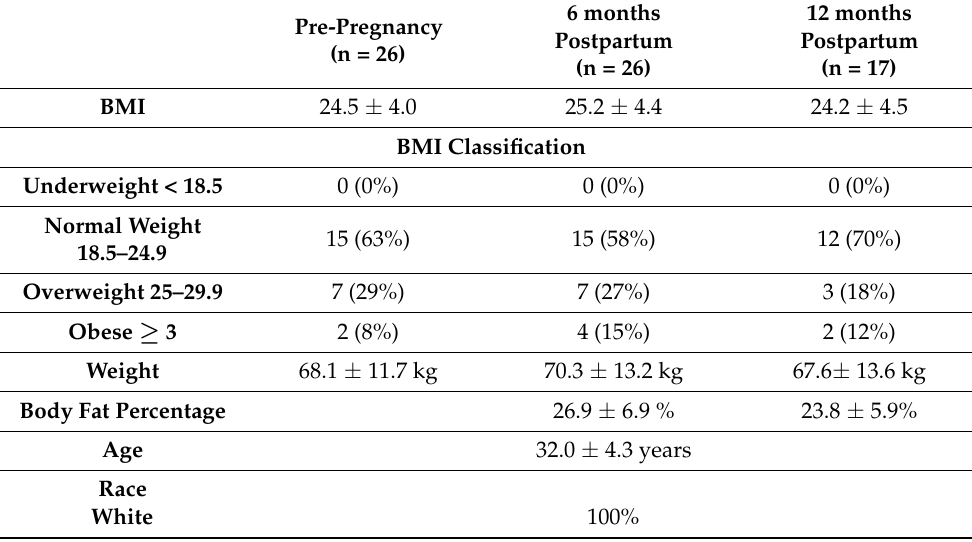
Table 1. Descriptive statistics for the